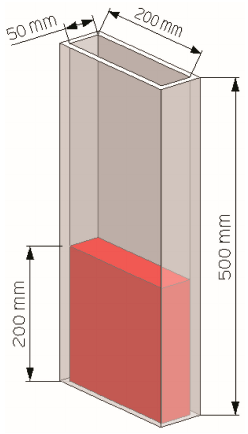
Figure 1. Schematic representation of the fluidized bed. Table 1. Properties of particles.